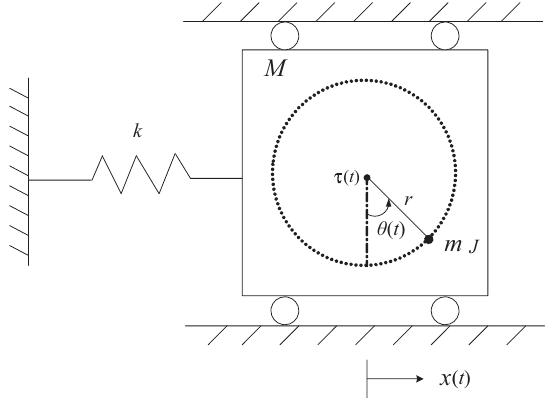
Figure 1. Physical model of the TORA